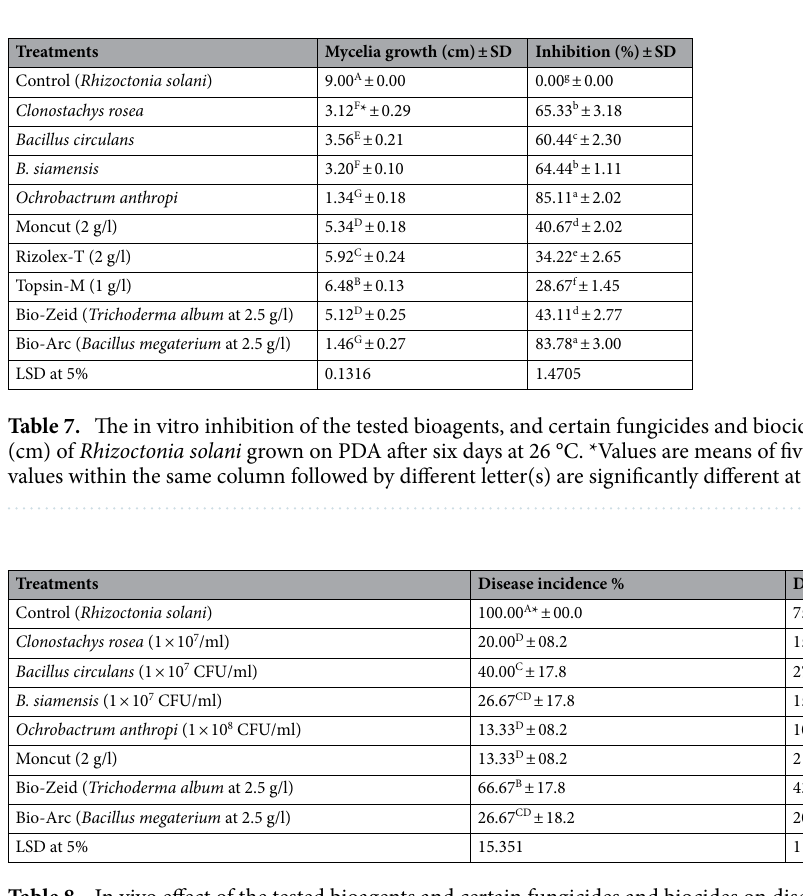
Table 8. In vivo effect of the tested bioagents and certain fungicides and biocides on disease incidence and severity caused by artificial infection with Rhizoctonia solani on lucky bamboo in vase, after 4 weeks under laboratory conditions. *Values are means of five replicates, each replicate contains three bamboos (plant/vase) of each treatment; Values followed by different letter(s) within the same column are significantly different at 0.05% level of probability.